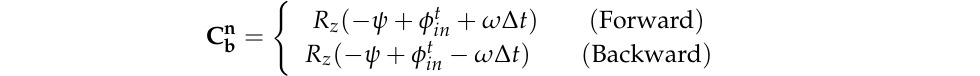
Figure 9. Stair error of azimuth ( ω = 12°/s). According to the analysis above and Equation (10), the asynchrony between the gyroscope and angular encode can be solved. The asynchrony is .